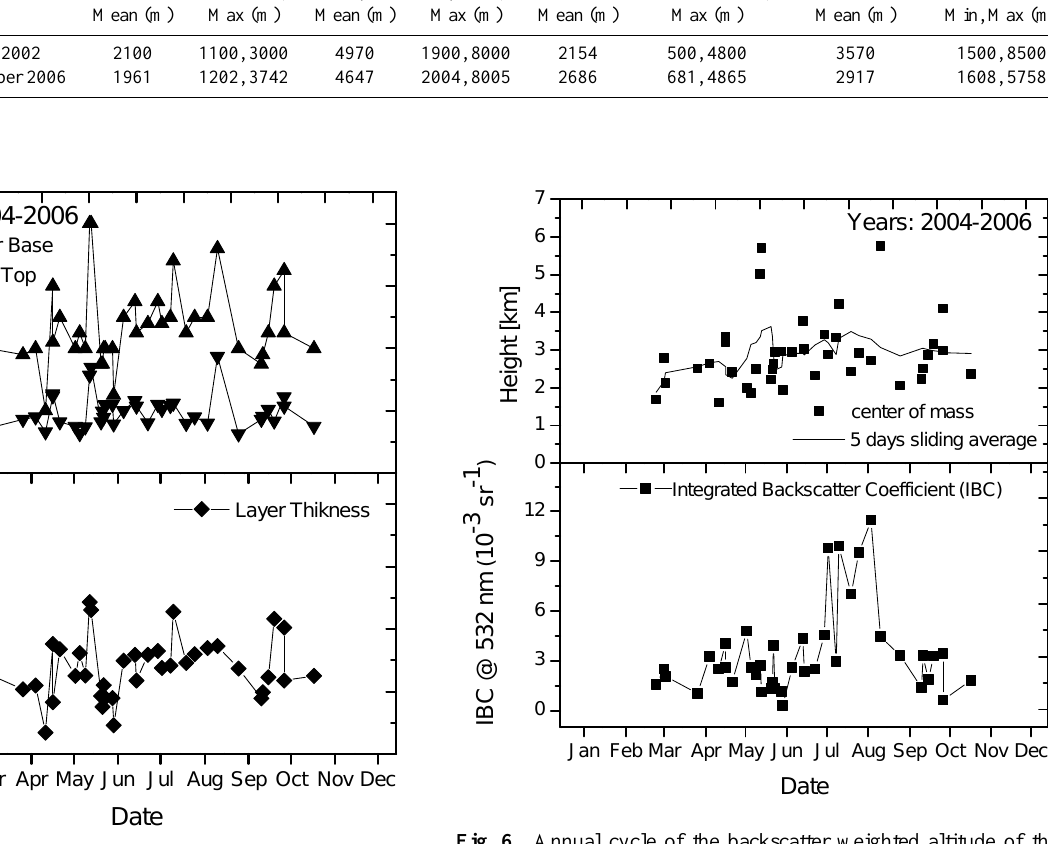
Fig. 5. Annual cycle of the base and top of the dust layer (upper part) and of the layer thickness (lower part) for the three-year period (January 2004–December 2006).